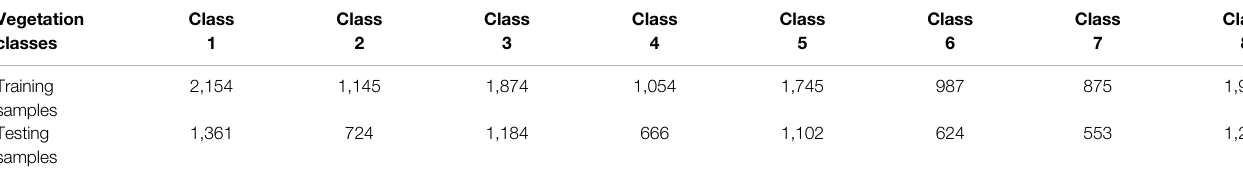
TABLE 2 | Training and testing sample sizes (in pixels) used for vegetation classi fi cations.